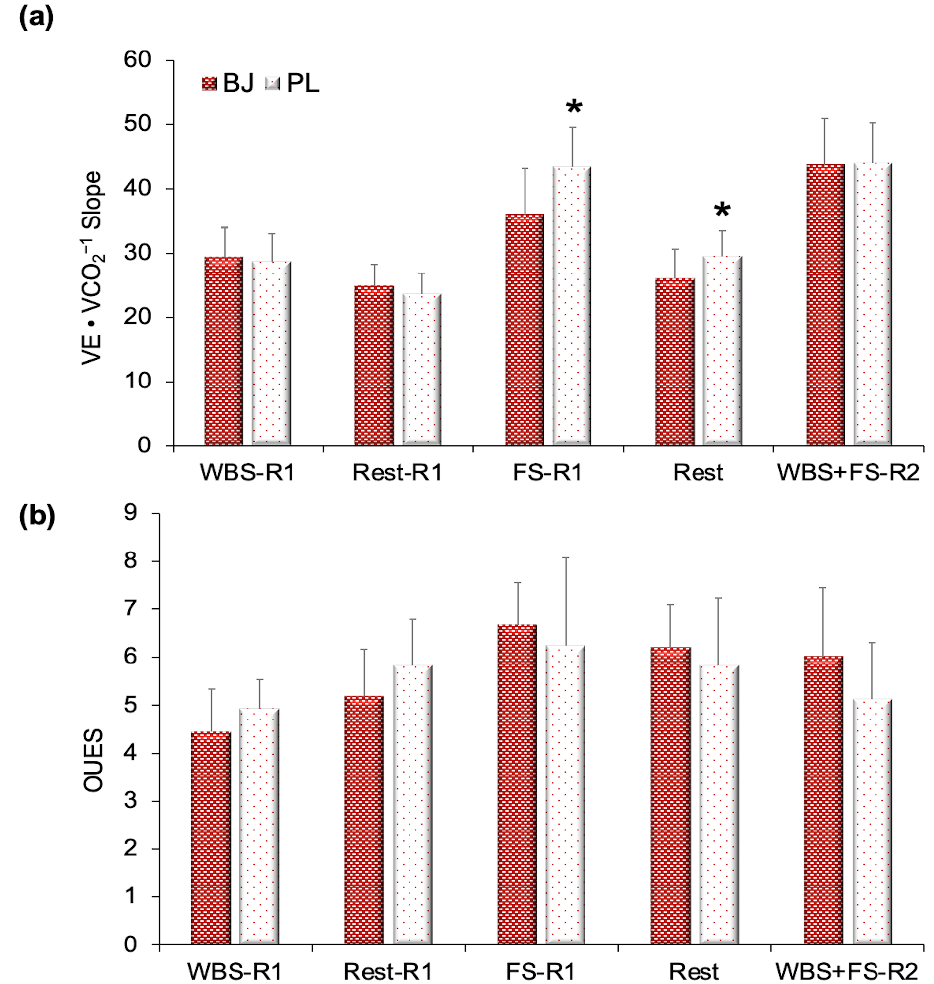
Figure 3. Differences between beetroot juice intake and the placebo ( n = 11). ( a ) VE • VCO 2 − 1 slope ( b ) OUES. Abbreviations used: BJ: beetroot juice; FS-R1: full squat during the first routine; OUES: oxygen uptake efficiency slope; PL: placebo; WBS-R1: wall ball shots during the first routine; WBS+FS-R2: wall ball shots plus full squat during the second routine (without a rest). Data are provided as mean and error bars as 95% confidence intervals. * Significant increase in the VE • VCO 2 − 1 slope after the PL intake compared with BJ ( p < 0.05). In the VE • VCO 2 − 1 2 slope, VE and VCO 2 were highly correlated ( p < 0.001) in the two experimental conditions (Figure